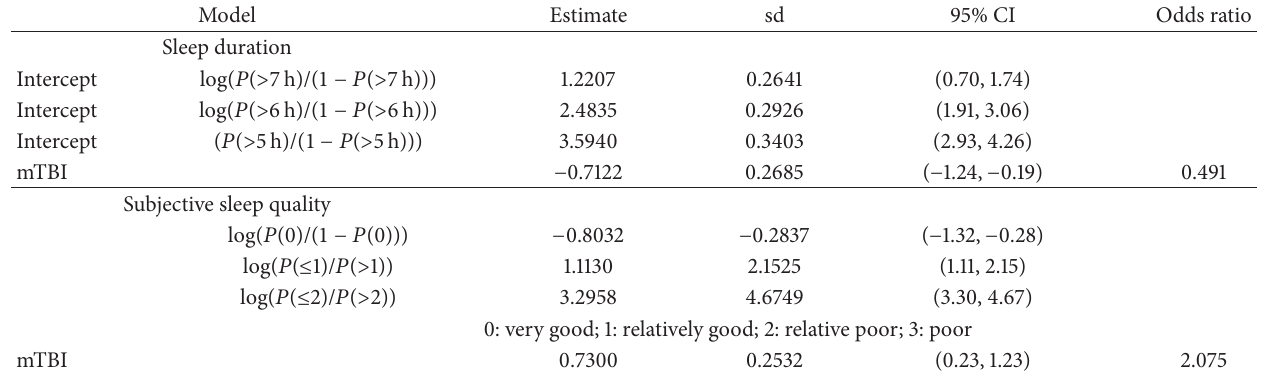
Table 6: Results of the proportional-odds cumulative logit